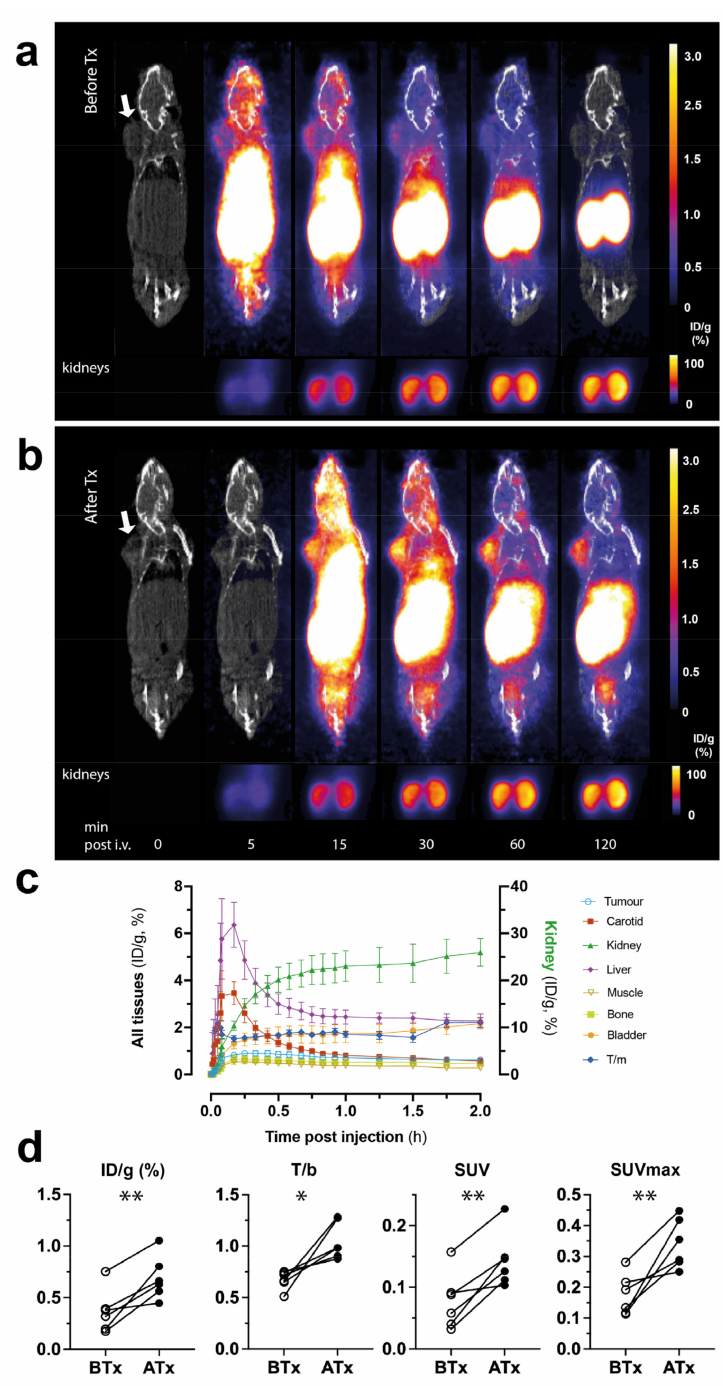
Figure 4. PET/CT images of 68 Ga-C2Am accumulation in subcutaneous COLO205 tumors (white arrows). ( a ) Before treatment (BTx) and ( b ) 24 h after treatment with MEDI3039 at 0.4 mg/kg (Atx). Maximum intensity projections from representative mice. Images were acquired for up to 120 min after intravenous injection of 68 Ga-C2Am. Signal (ID/g, %) is overlaid on a skeleton mask derived from CT images. ( c ) Activities (ID/g, %) in the indicated tissues in drug-treated animals (MEDI3039, 0.1–0.4 mg/kg, 24 h). ( d ) Pairwise analysis of PET signals before and 24 h after treatment at 2 h after probe administration, expressed as ID/g (%), tumor-to-blood (T/b) ratio, SUV, and SUVmax. Two-tailed, pairwise t -test, * p < 0.05, ** p < 0.01. Data in ( c , d ) are mean ± SEM, N =